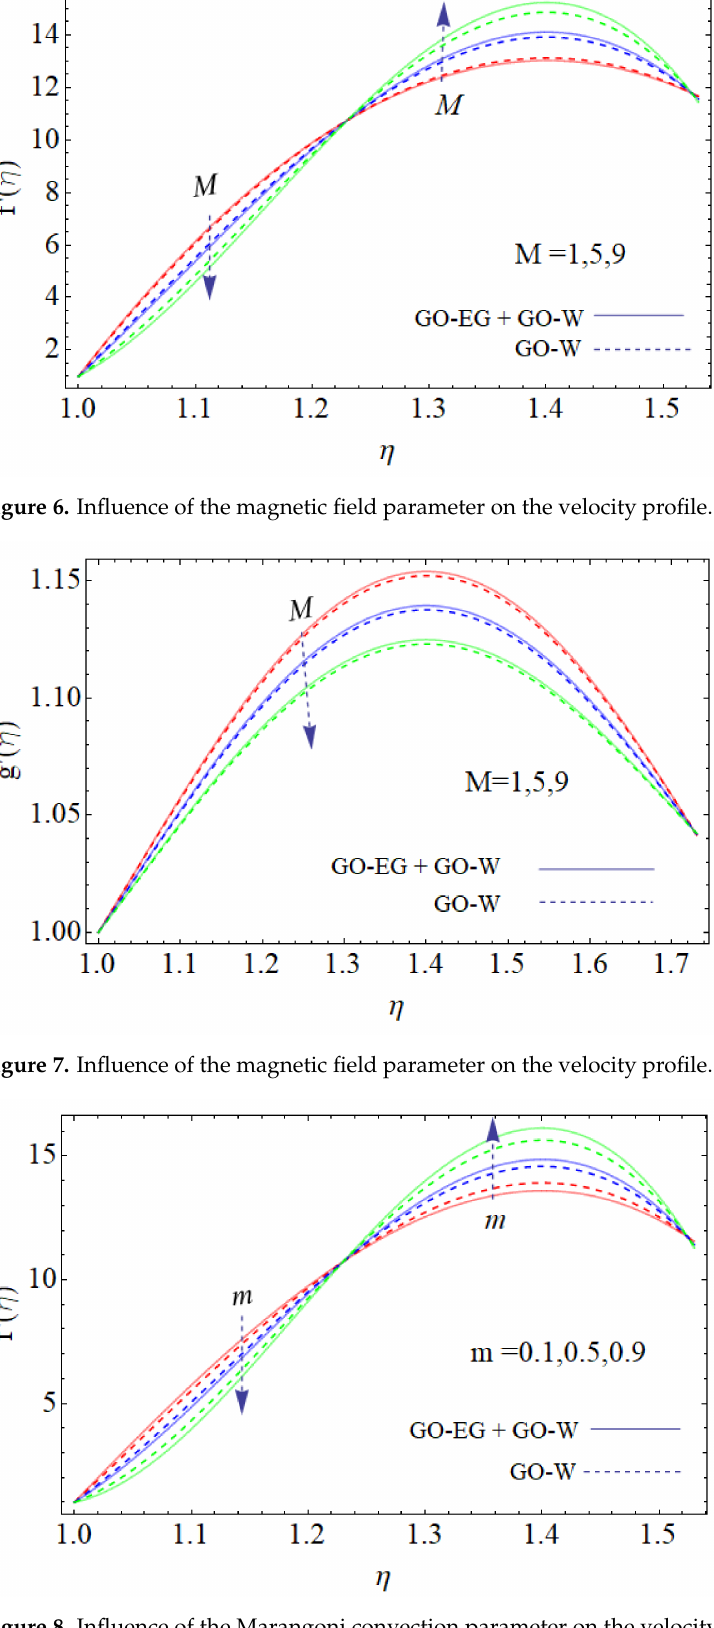
Figure 8. Influence of the Marangoni convection parameter on the velocity